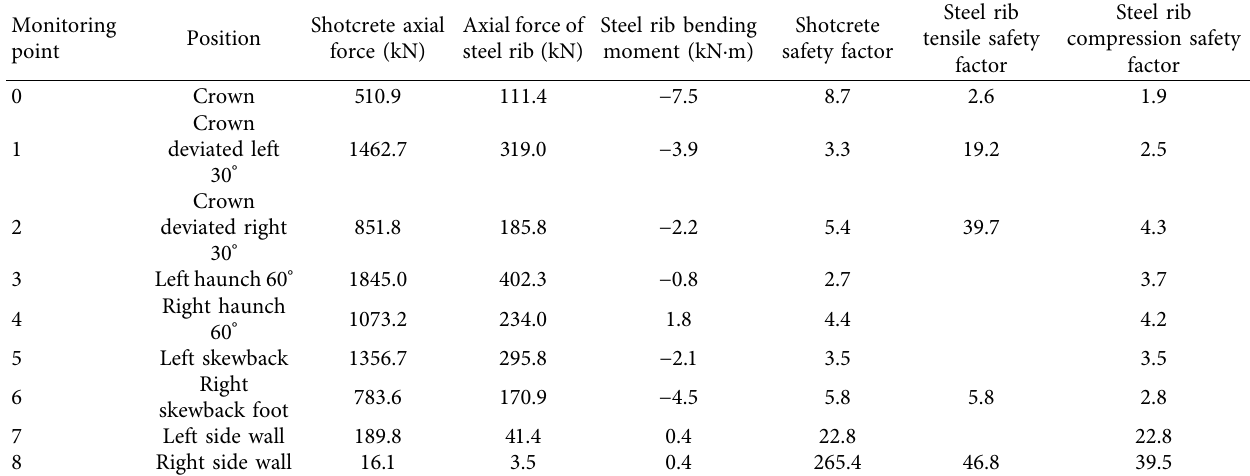
Table 10: Internal force and safety factor of primary support under parameter